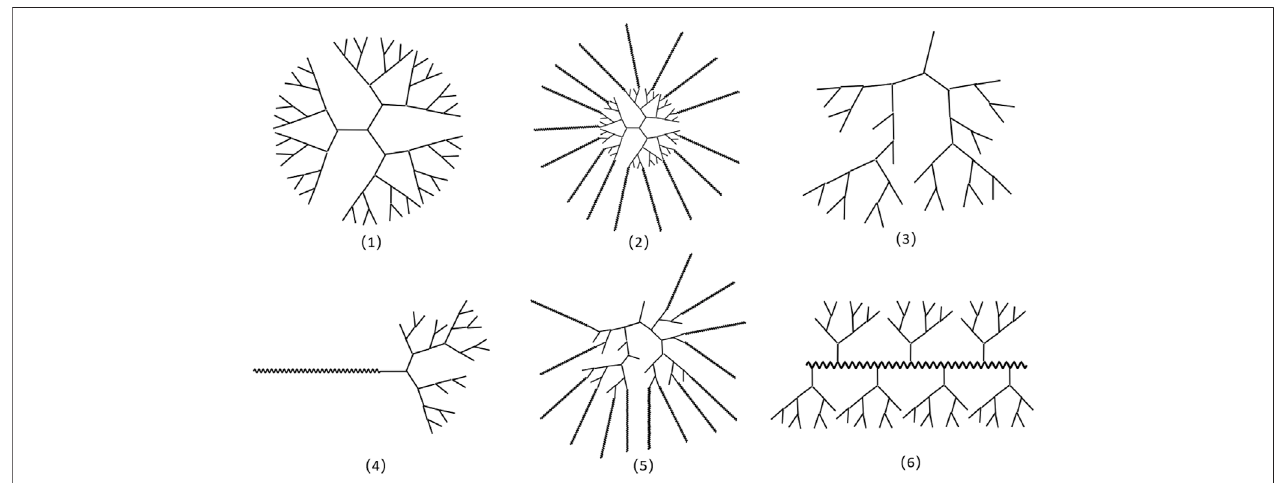
FIGURE 1 | Schematic structure of hyperbranched polymers: 1) dendrimer structure without grafting; 2) dendritic-linear grafted polymer structure; 3) hyperbranched macromolecularstructurewithoutgrafting;4)hyperbranched-linear graftedsingle-arm structure;5)hyperbranched-linear graftedmulti-arm structure; 6) hyperbranched grafted structure (Gao and Yan,